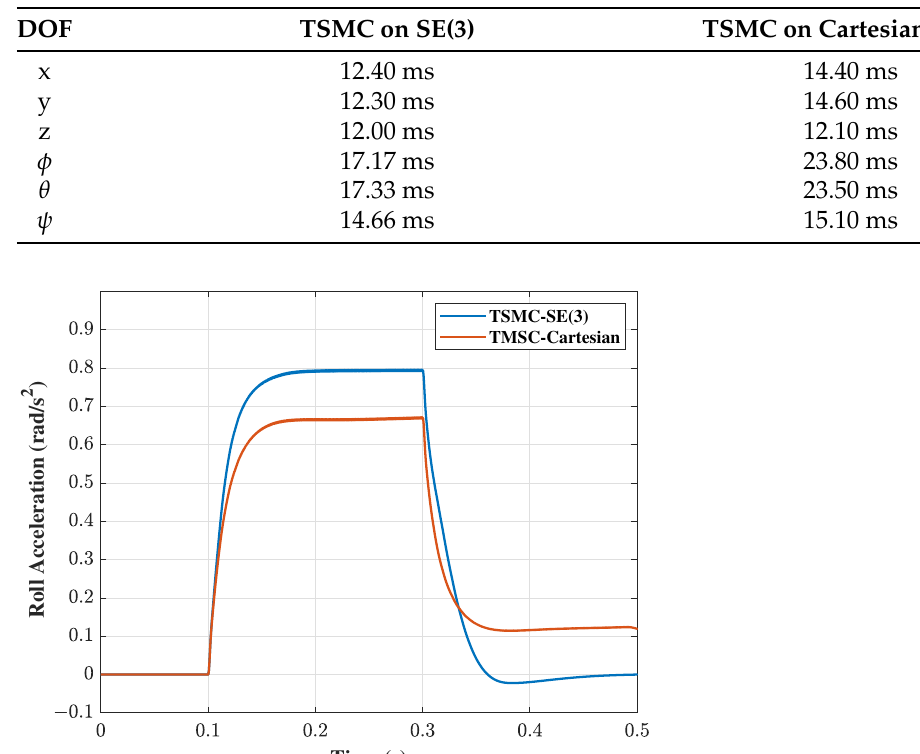
Table 5. The rise time comparison for TSMC on SE(3) and Cartesian space.